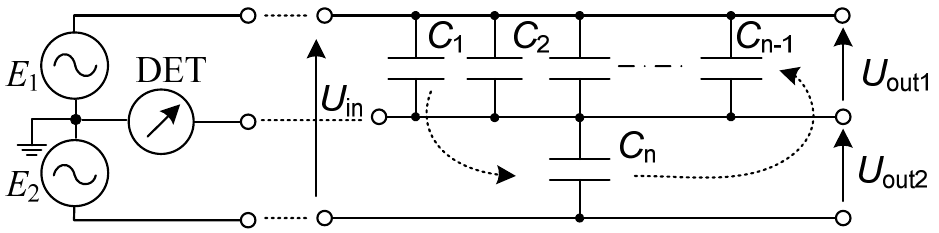
Figure 1. A scheme presenting idea of the permuting capacitors.